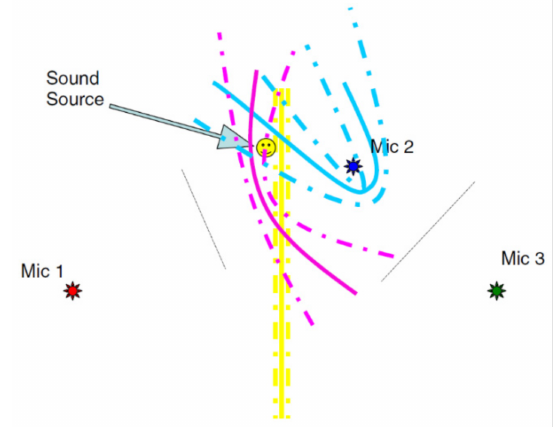
Figure 7. A three microphone configuration